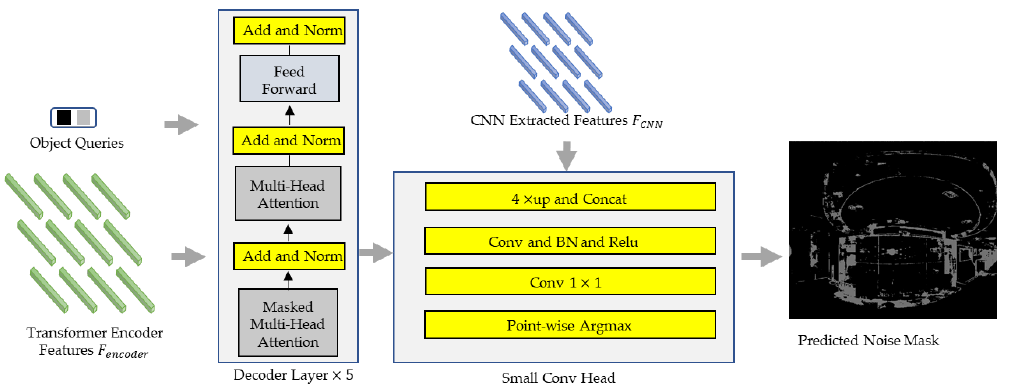
Figure 7. Transformer decoder